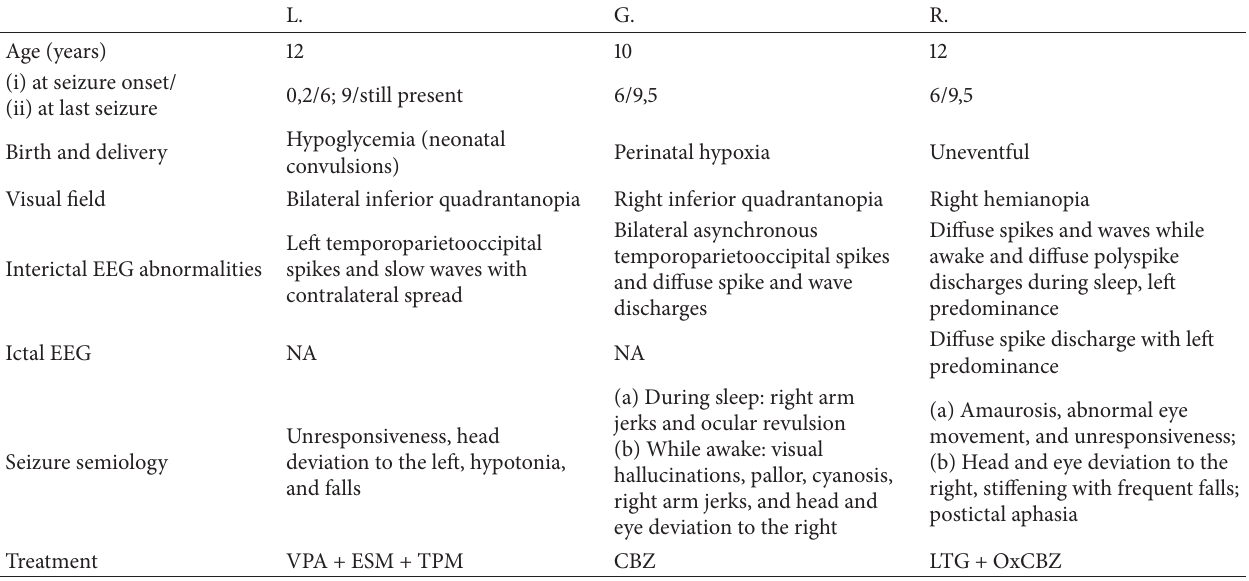
Table 1: Clinical characteristics for each child ∗